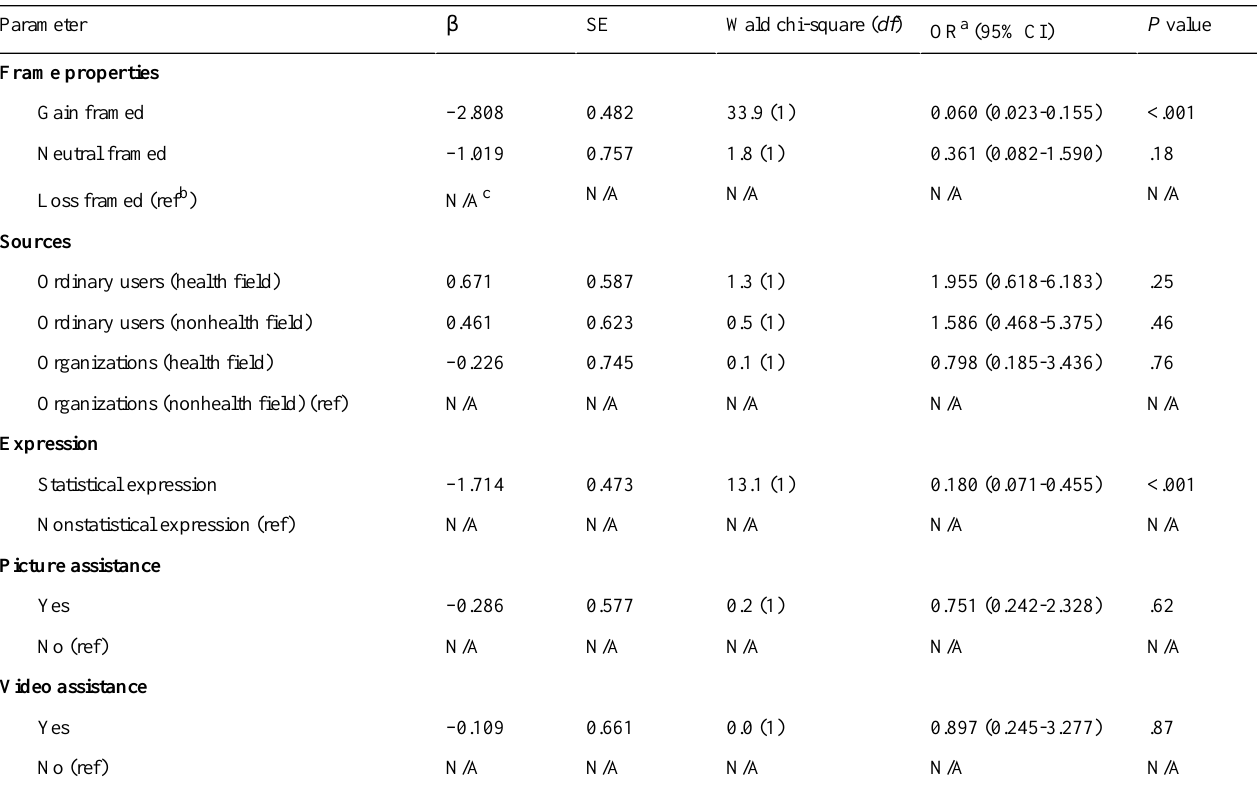
Table 4. Binary logistic regression for health-promoting messages regarding